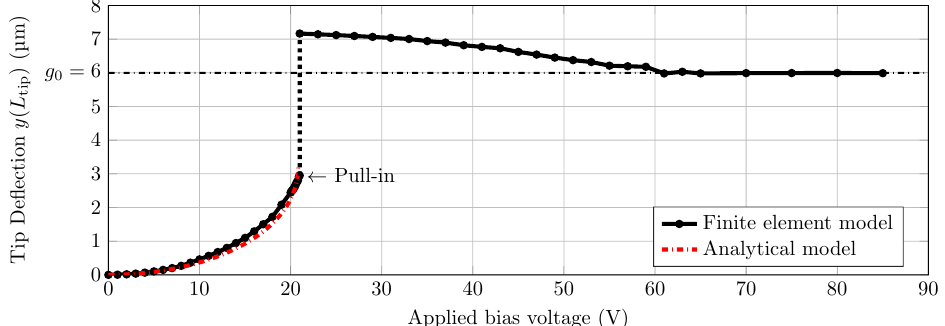
Figure 5. The shape of the cantilever is shown as a function of the position along the length of the cantilever. This is shown for a varying voltage.